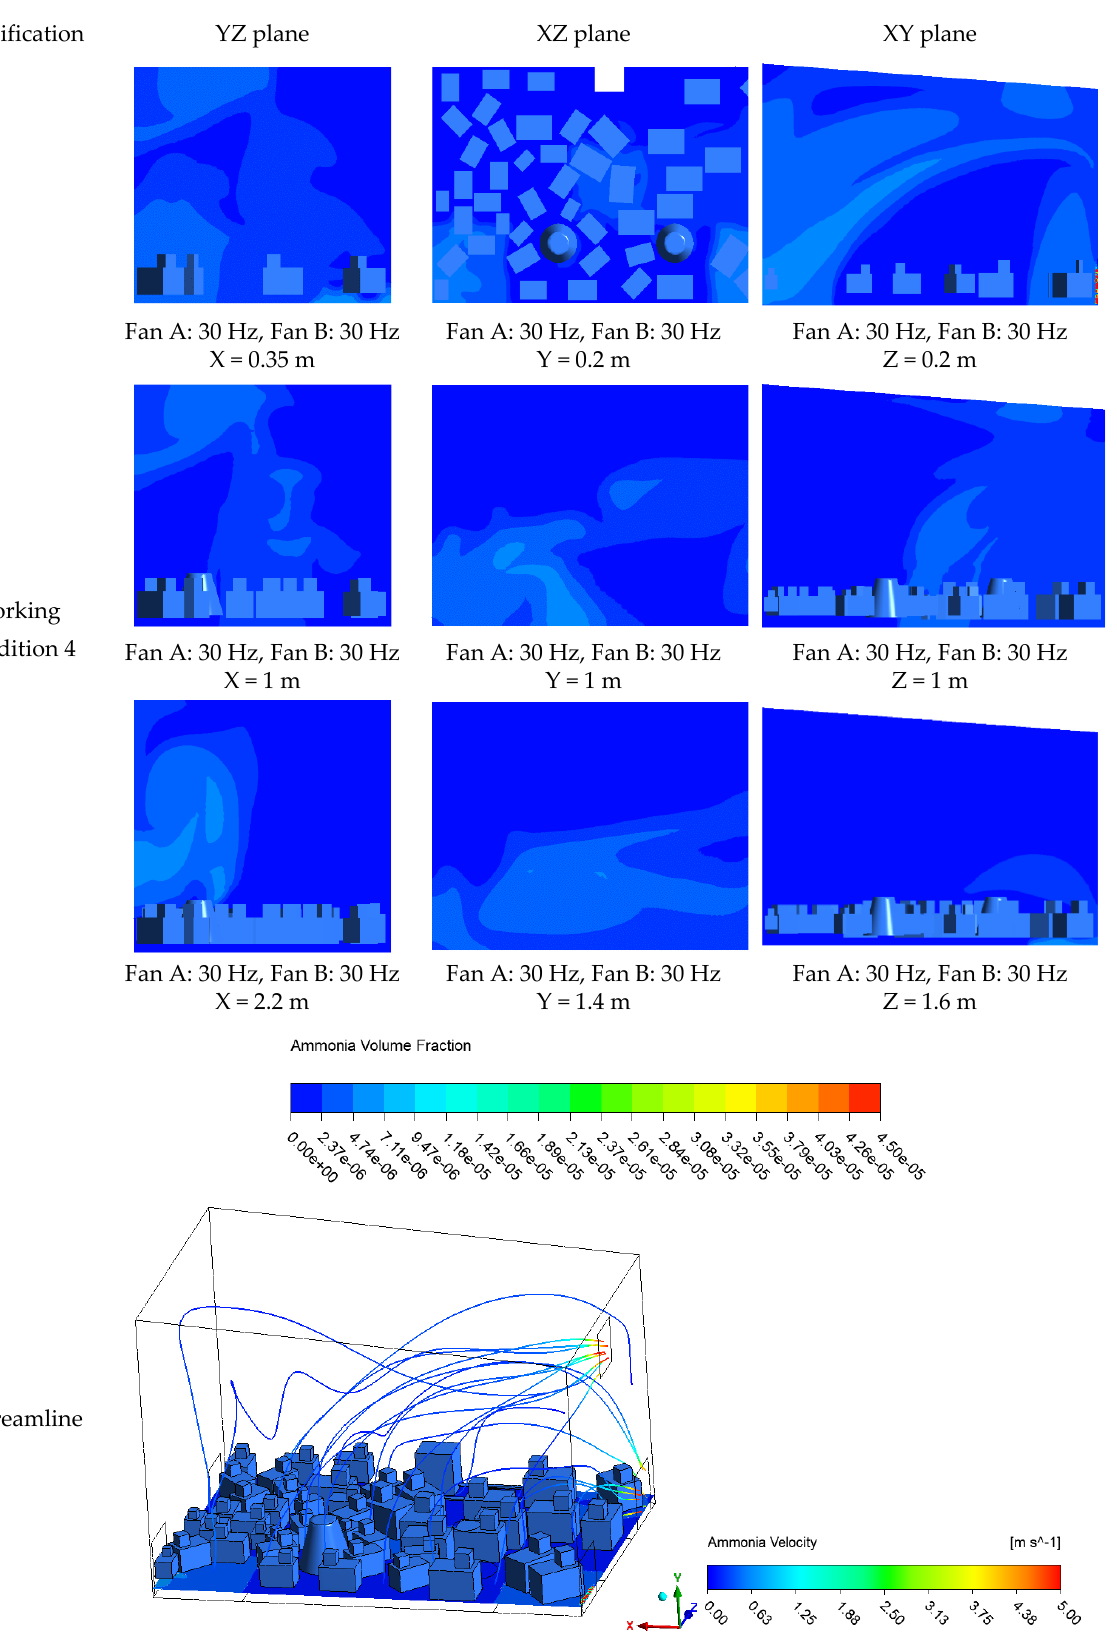
Figure 13. Simulation results of ammonia concentration distribution under working condition 4. As indicated by comparing the optimized and original results, the ammonia concen- tration in the broiler chamber in the optimization scheme is the lowest. When the internal and external circulation fans are turned on at 10 Hz, it can be found that the scheme of the “ the internal and external circulation fans of 10 Hz with added negative pressure ” can better achieve the uniformity of ammonia concentration in the chamber. Meanwhile, the ammonia at the top of the broiler chamber can be discharged more efficiently. By observ- ing the flow diagram, it can be concluded that in the original ventilation method, the am- monia far away from the fan wall is generated from the floor layer and needs to rise to the roof then descend to the external circulation outlet to be eliminated; meanwhile, the neg- ative pressure fan in the optimized scheme can directly eliminate the ammonia on the top of the broiler chamber. 4. Conclusions In this paper, CFD technology was used to simulate ammonia production and iden- tify the characteristics of its concentration in a smart broiler chamber in Nanjing, China. The models of the smart-breeding broiler chamber and the corresponding broilers were constructed based on field monitoring: first, the grid was reasonably meshed into discrete computing domains for each model, and second, the boundary conditions were deter- mined accordingly. In the process of simulating the distribution of ammonia concentra- tion in the broiler chamber during winter, the SST K- ω model was applied as the steady - state turbulence model, and the structure of the chamber was optimized based on the sim- ulation results. The simulation results demonstrated that under working conditions 1 and 2, the ven- tilation fan could not provide the flow rate to meet the ammonia concentration require- ments of the broiler chamber, as the ammonia distribution was uneven, and the ammonia concentration in the living layer of the broilers was relatively high. The ammonia concen- tration in the chamber could be controlled to reach lower than 20 ppm under working conditions 3; however, attempts to reach the working temperature during winter was highly tricky. The broiler chamber structure was reformed on the basis of the simulation results, and a negative pressure fan was placed in the middle part of the chamber above the internal and the external circulation fans on the fan wall, to improve the uniformity of the air flow in the chamber. This modification to the broiler chamber significantly im- proved the uniformity of the ammonia, and allowed the ammonia concentration in the chamber to remain below 10 ppm. This treatment effectively reduced the ammonia con- centration in the living layer of the broilers and accelerated the ammonia discharge.